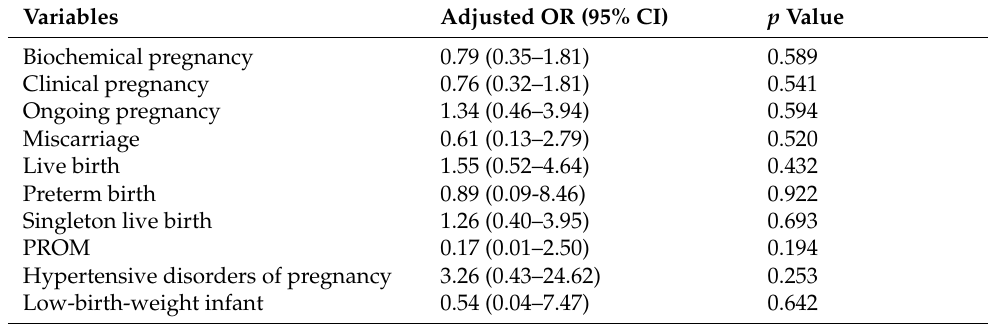
Table 4. Adjusted OR of pregnancy outcomes and obstetric complications between freeze-all and fresh